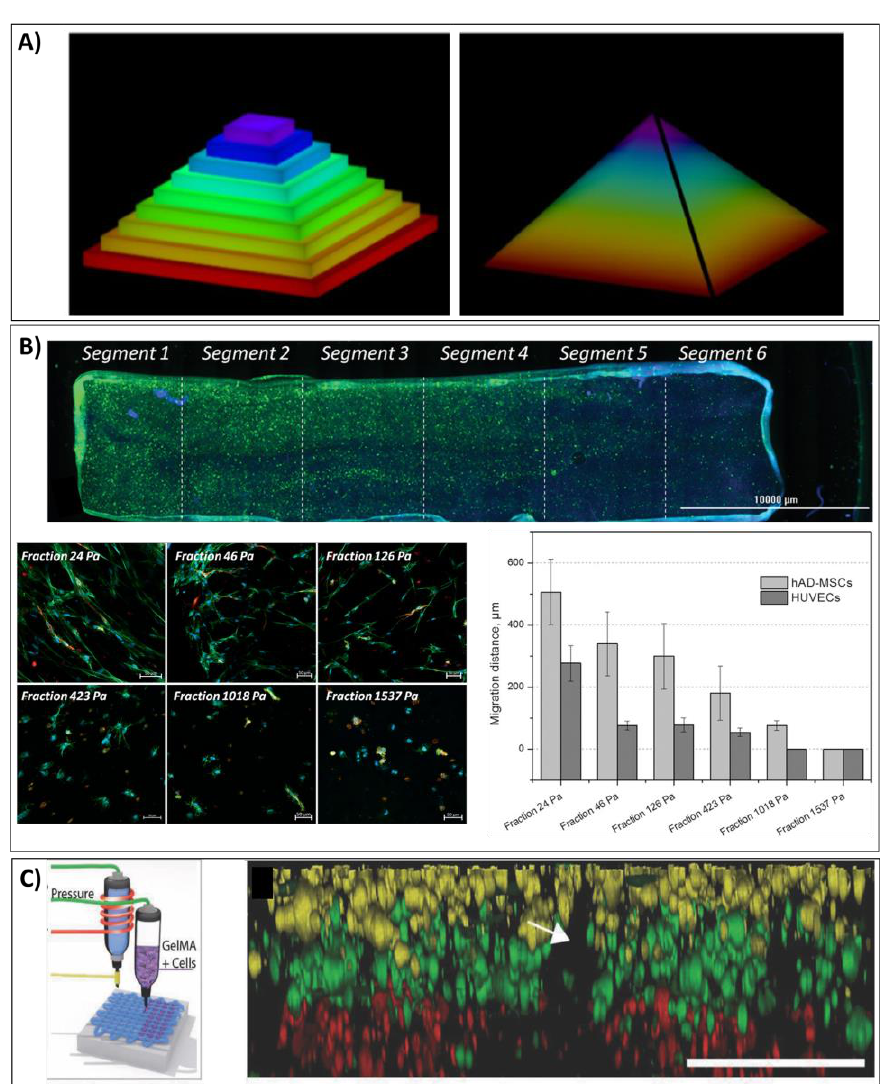
Figure 6. The new era of biofabrication is moving from low-resolution layer-by-layer stacking of objects with a limited volume and into high-resolution printing by decreasing the layer height to generate a smoother surface ( A ). Reprinted with permission from ref. [195]. Bioprinting of GelMA with a controlled stiffness gradient allows encapsulated HUVECs (blue tracker) and adipose derived MSCs (green tracker) to be encapsulated with spatial gradients ( B ). After 7 days of culture, immunohistology of f-actin (green), CD31 (red), and DAPI (blue) demonstrated that cells had very distinct morphologies depending on the stiffness of the local material, making these mechanical gradients a powerful tool to control cellular phenotypes ( B ). Reprinted with permission from ref. [209]. Using melt-electrowriting combined with extrusion-based bioprinting of GelMA bioinks enables the layered distribution of various MSC mixtures (red, green and yellow) demonstrating a smooth transition between layers, which represents a key step towards more controllable and complex hierarchical structures ( C ) . Reprinted with permission from ref. [212].